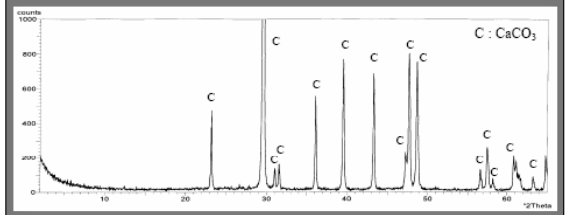
Fig. 6. Radiogram of the calcite observed on the surface of various concretes.